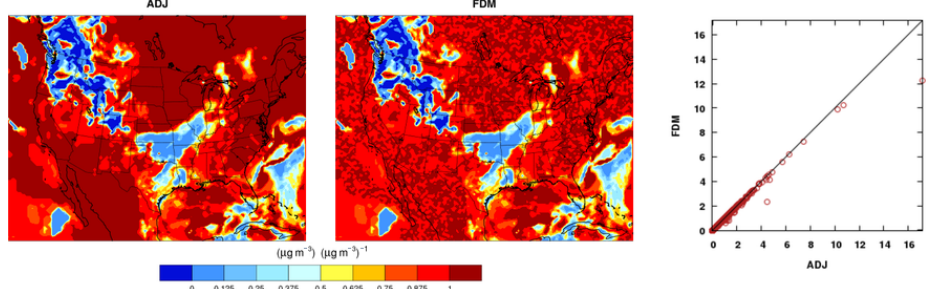
Figure 5. Evaluation of sub-grid cloud mixing with the ADJ (adjoint) against the FDM (finite-difference method) sensitivities of the final concentrations of an accumulation-mode aerosol species ASO4J (µgm − 3 ) with respect to the initial ASO4J (µgm − 3 ) from a 1d test run. The perturbation size for the FDM is 0.01µgm − 3 .